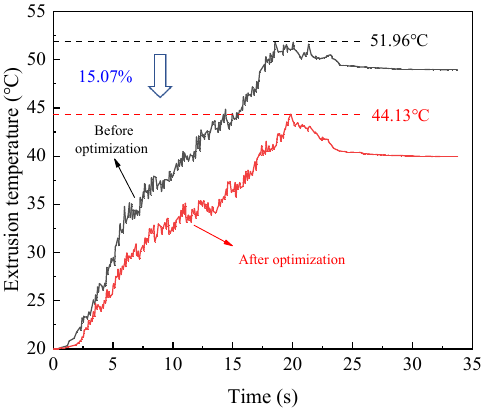
Figure 26. Optimization results of extrusion